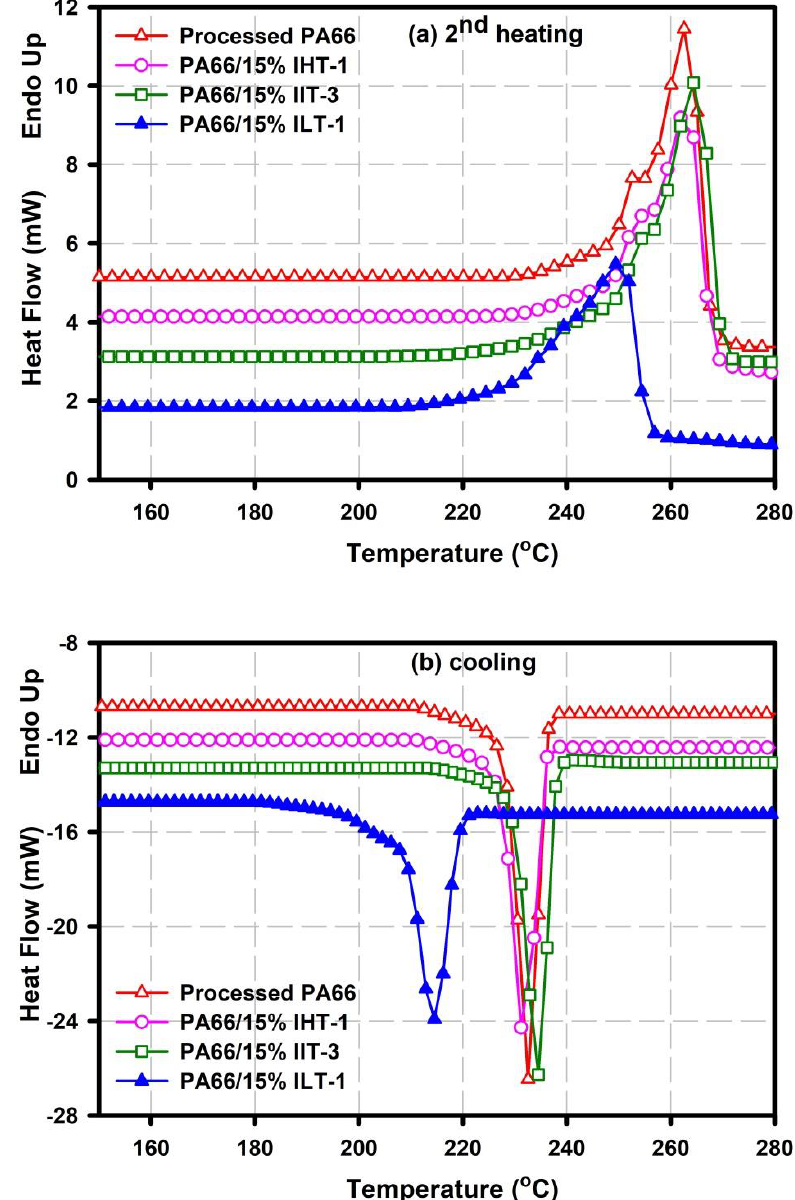
Figure 1. ( a ) 2 nd heating, and ( b ) cooling di ff erential scanning calorimetry (DSC) thermogram for the studied PA66 / P-glass systems and processed virgin